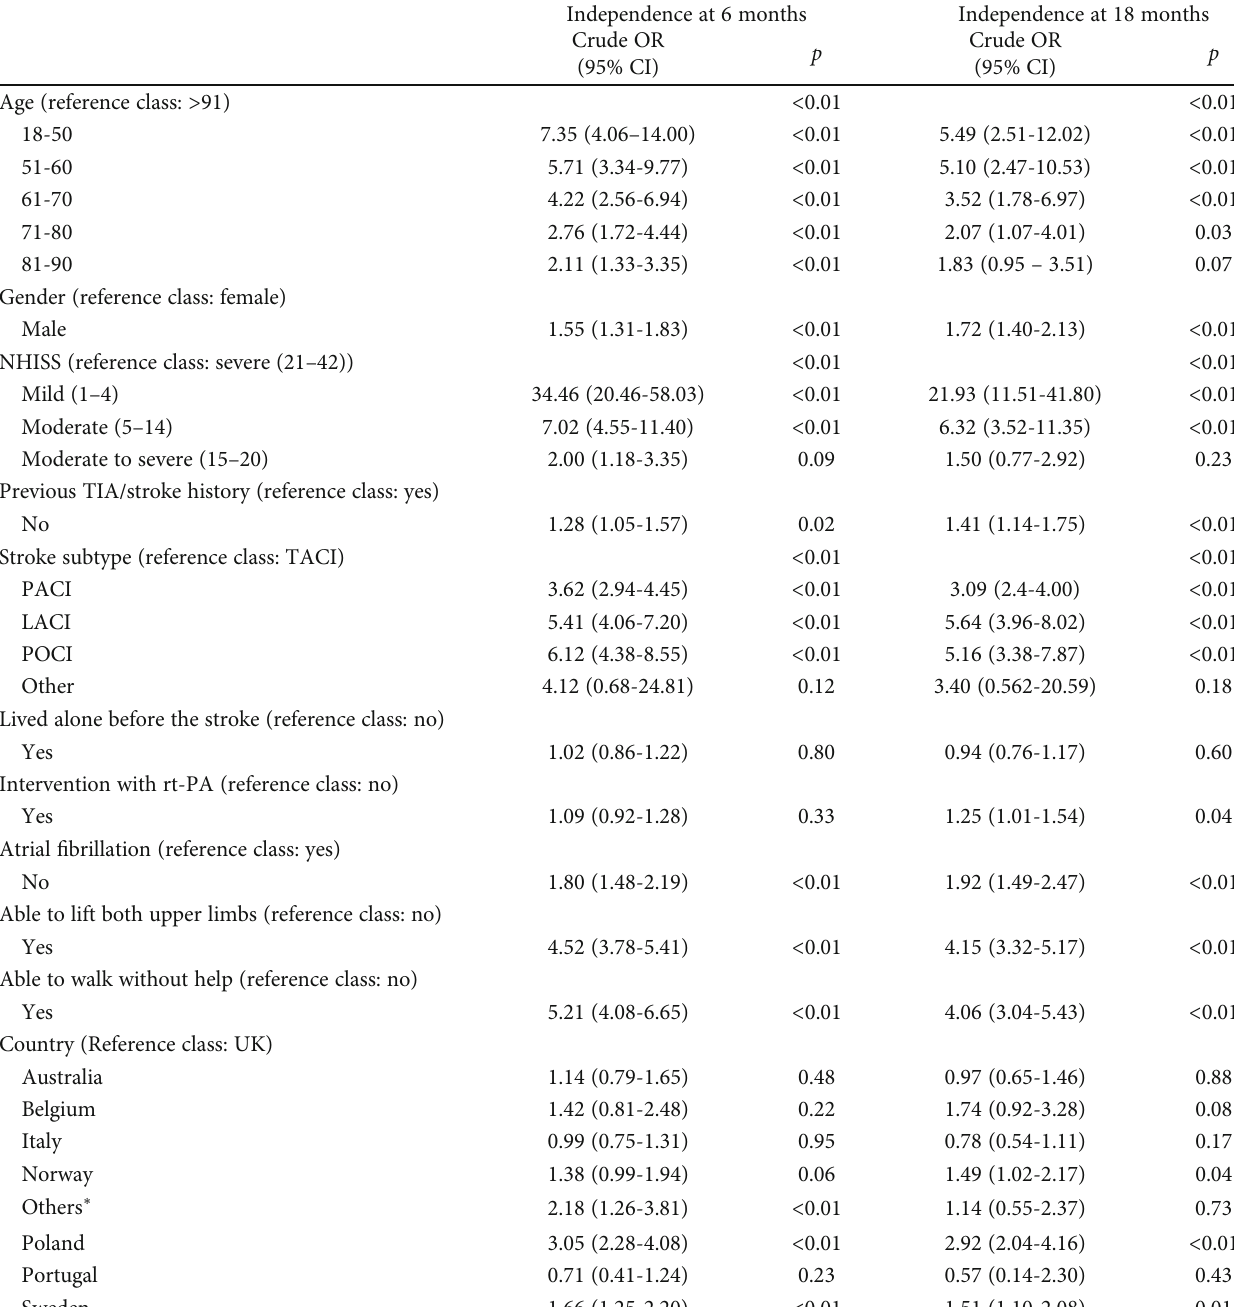
Table 2: Predictors for independence at 6 and 18 months poststroke, with OR and 95%